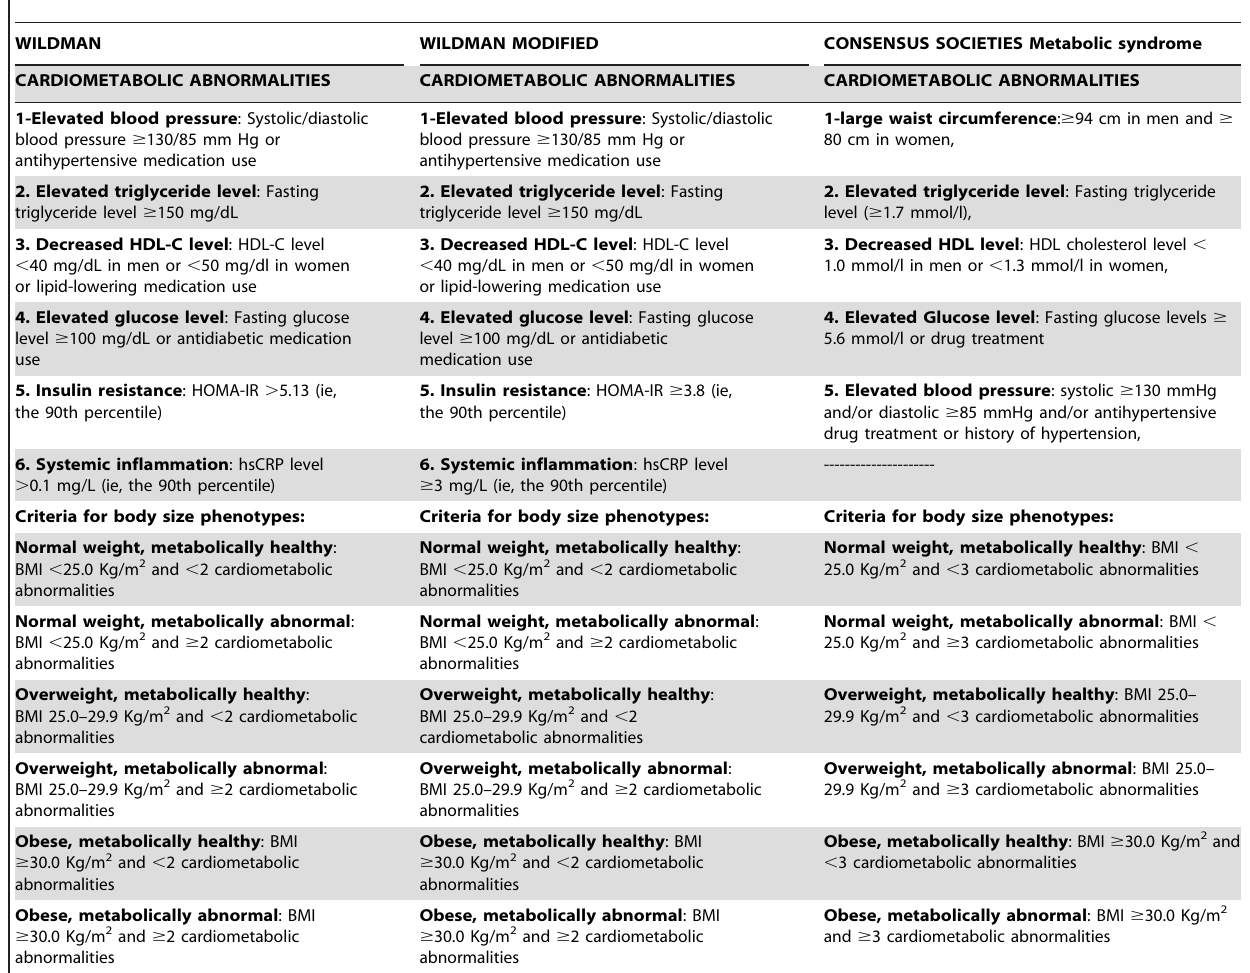
Table 1. Criteria: Wildman (W), Wildman modified (WM) and Consensus Societies (CS).